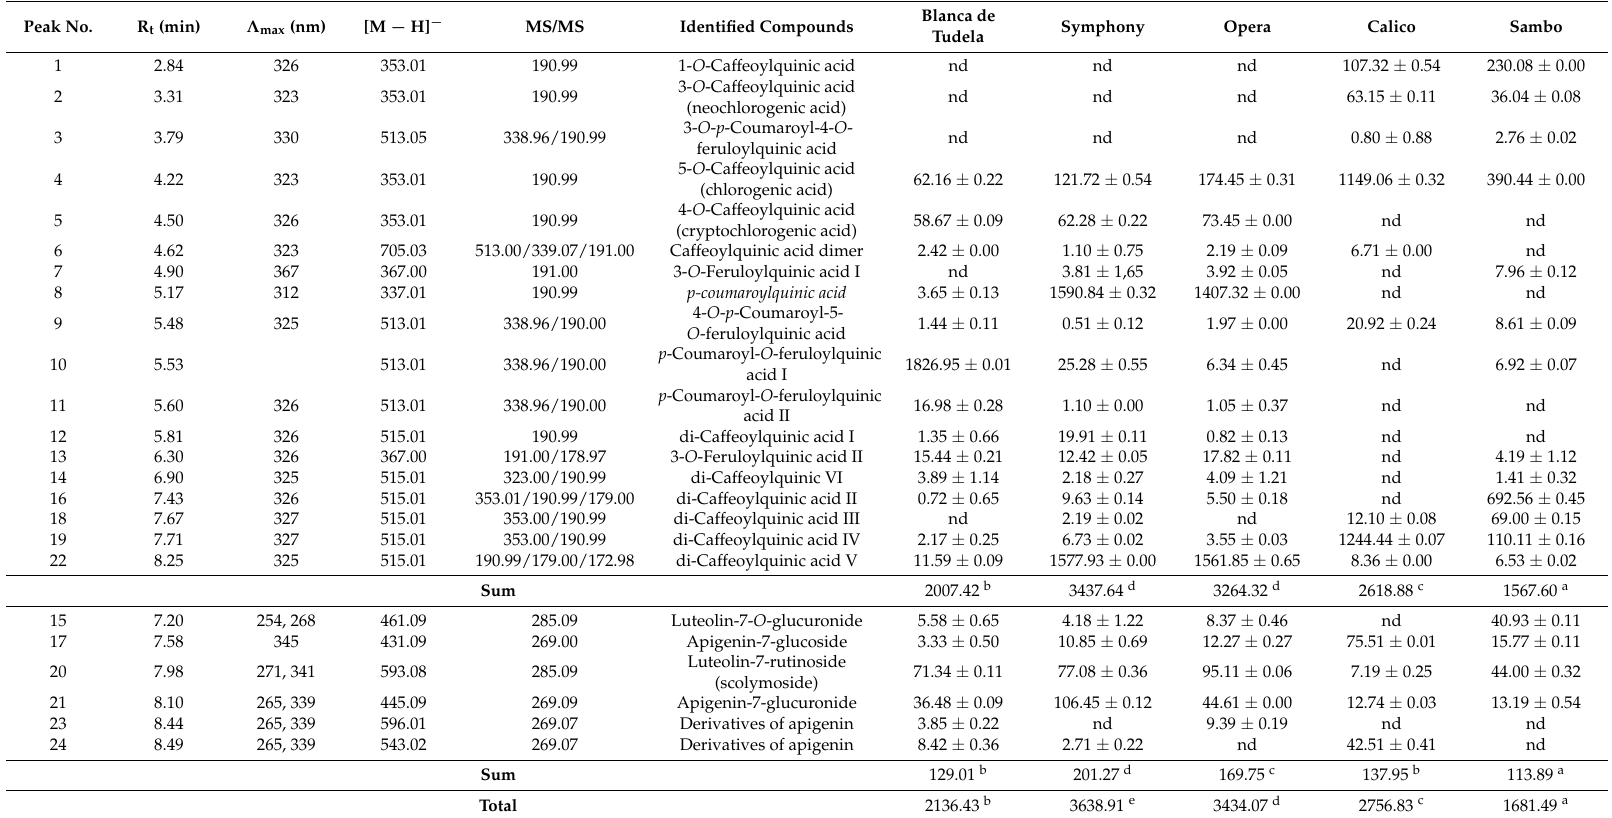
Table 3. Polyphenolic compounds in artichoke bracts (mg/100 g of dry matter). Peak